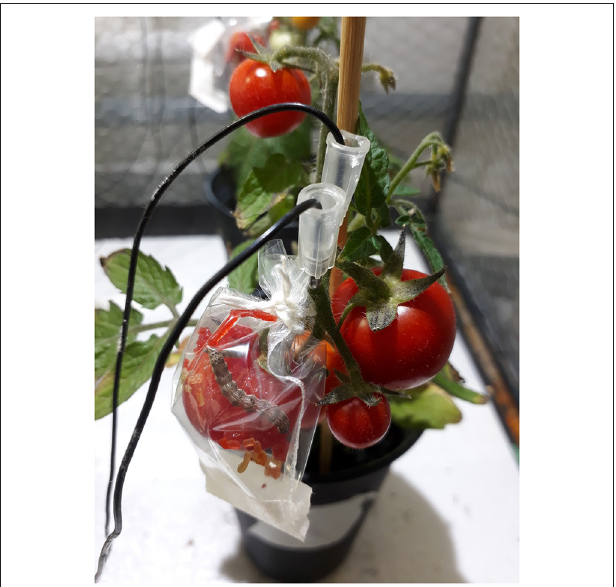
FIGURE 2 | “Micro-Tom” tomato fruit under herbivory. An electrode pair was placed in the peduncle, near the tomato fruit with Helicoverpa armigera caterpillar. Five tomato plants (1 control + 4 herbivory) were kept in Faraday’s cage for 24h, until the end of electrical signal acquisition.